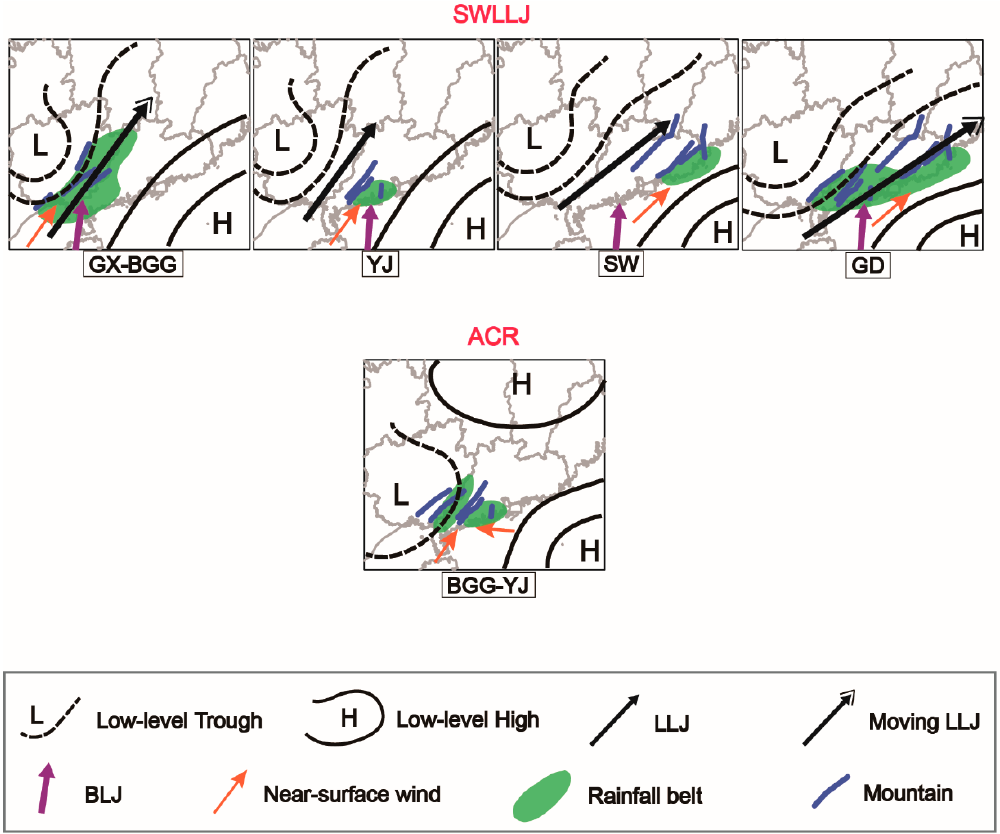
Figure 16. Schematic diagrams of SWLLJ and ACR synoptic situations and their relationship with the location, orientation, and extension length of OWSR. “LLJ” and “BLJ” indicate low-level jet and boundary-layer jet. “GX,” “GD,” and “BGG” indicate Guangxi and Guangdong provinces, and the boundary between them, respectively, and “YJ” and “SW” indicate Yangjiang city and Shanwei city in Guangdong